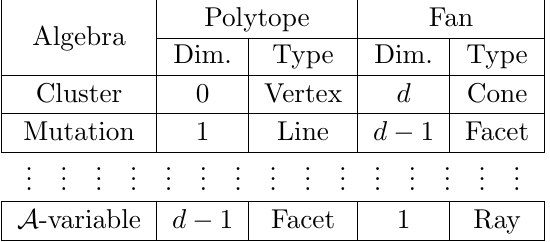
Table 1 . Comparison of the faces of a cluster algebra of rank d , its polytope and the cluster